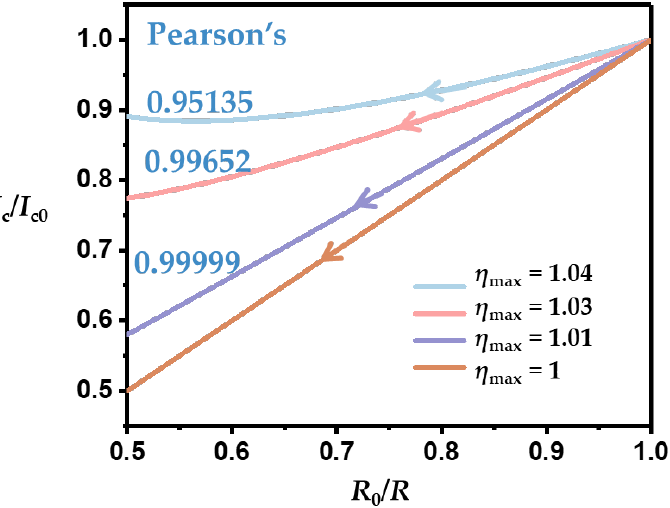
Figure 3. The influence of RC variation on I c / I c 0 vs. R 0 / R .